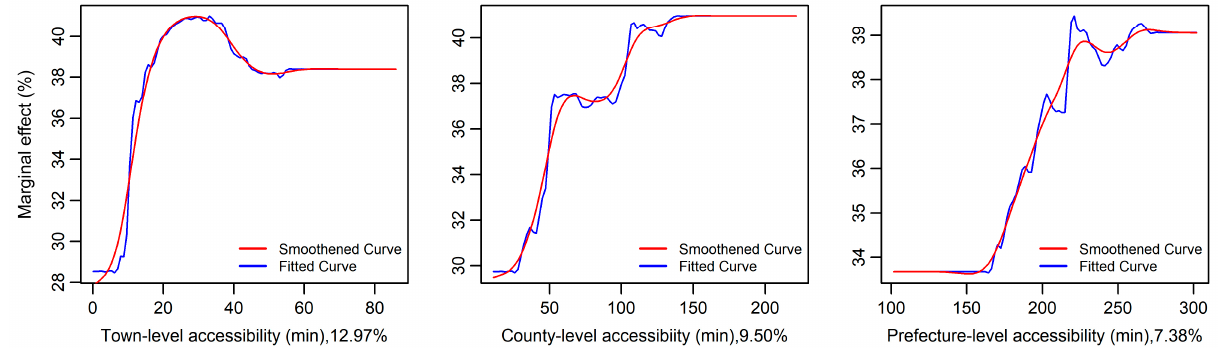
Figure 4. The relationships between multiscale transport accessibility and RPI.